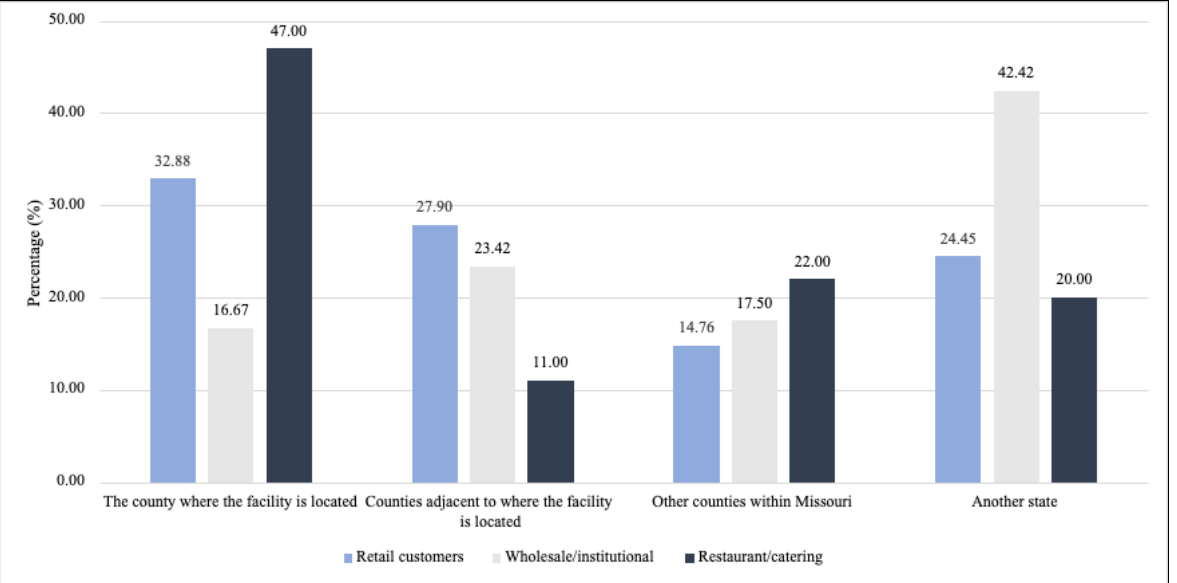
Figure 3. Locations of Customers from Different Distribution Channels ( N =26)